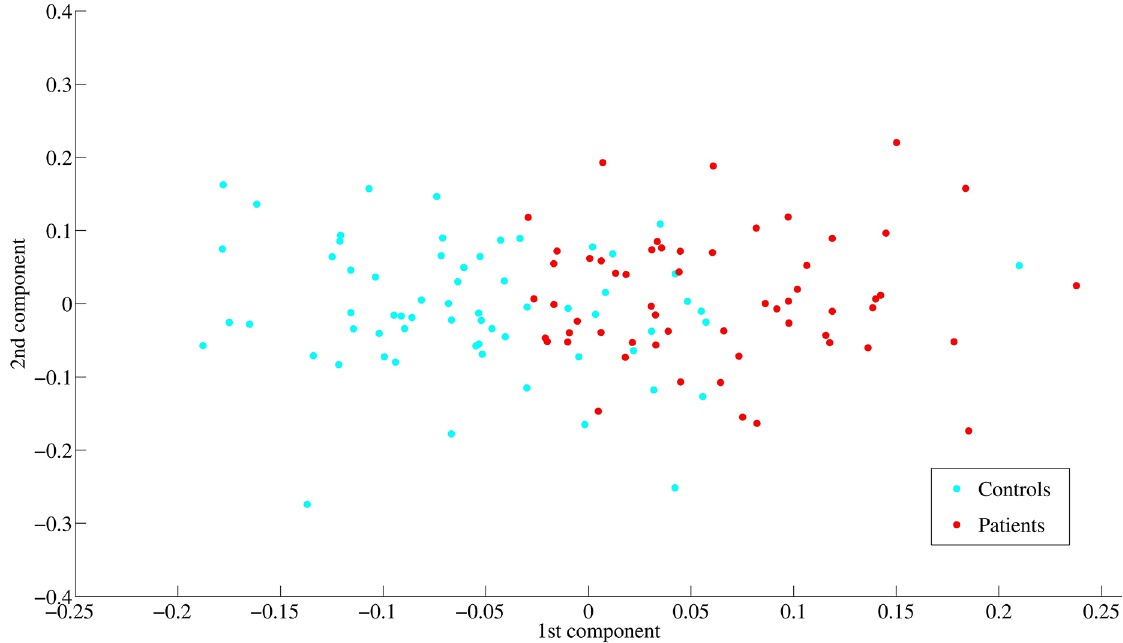
Fig 7. Scatter plot of the latent variables in the first two latent components generated from KPLS-Poly(2). Red and blue dots represent patients and healthy controls, respectively. The two groups are separatedmainly by the first latent component.